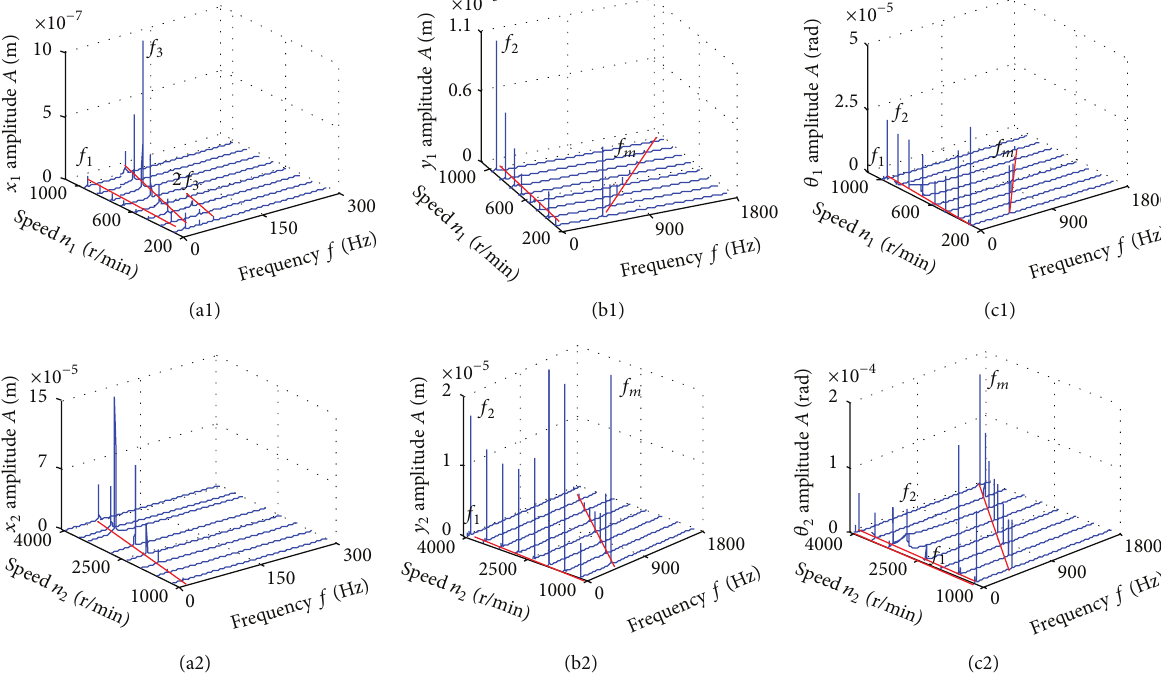
Figure 8: 3D frequency spectrum of the gears in lateral and torsional